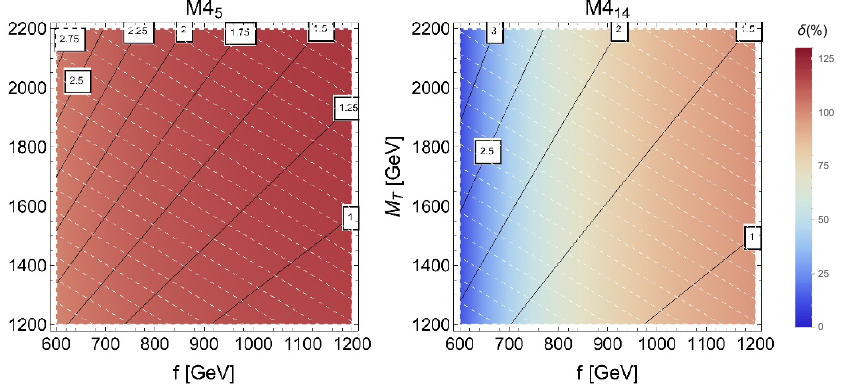
Figure 13 . The contour plots for (cid:14) with sin 2 (cid:18) R = 0 : 4 and p cut models with one top partner multiplet. The corresponding values of y are indicated by the solid lines. As indicated by the dashed white lines, all points on these plots result in (cid:20) t (cid:20) 0 :